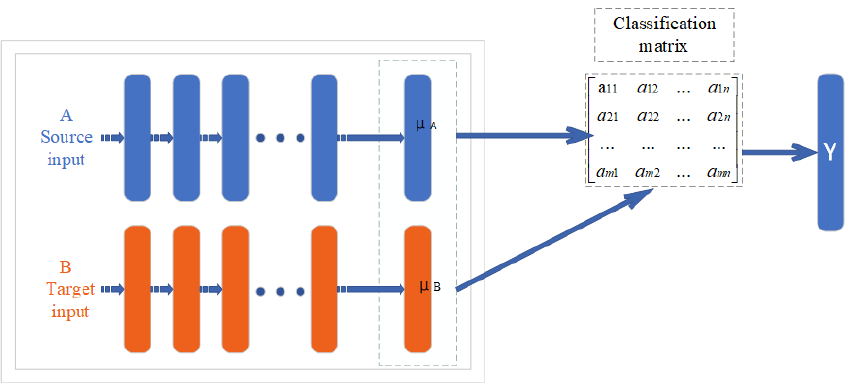
Figure 2. The process of federation